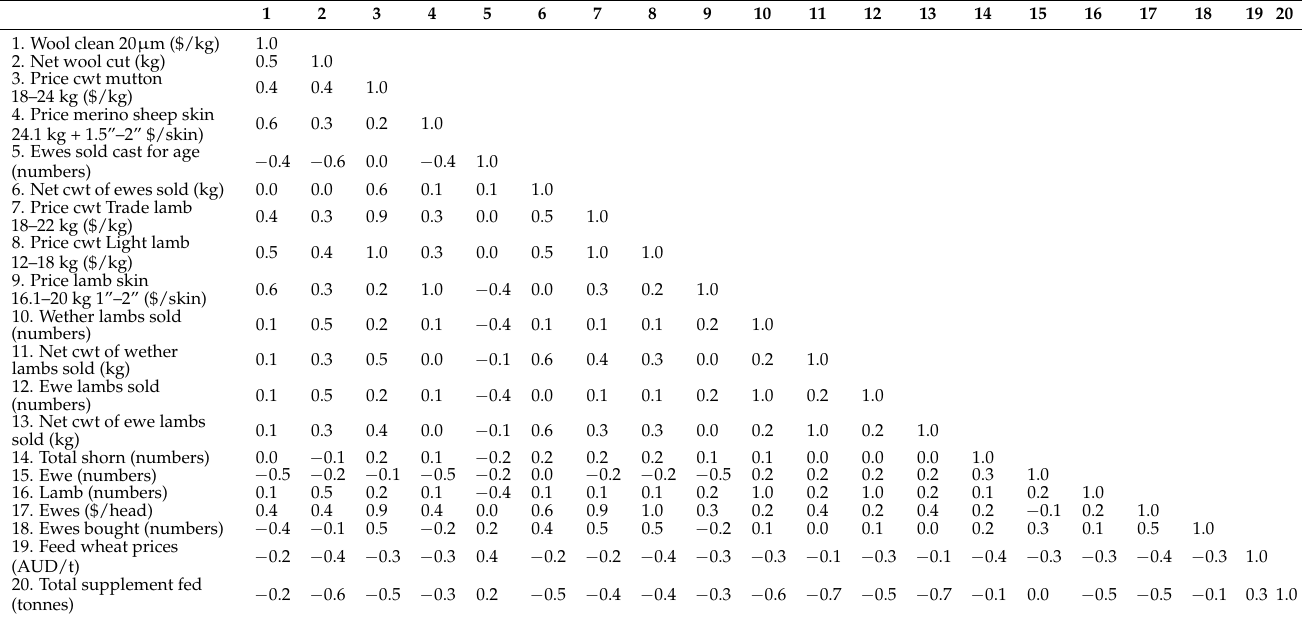
Table 3. Empirical correlation matrix for Gaussian copula for the total revenue and total variable cost (input variables) for the 1000 ha merino ewe and first-cross lamb